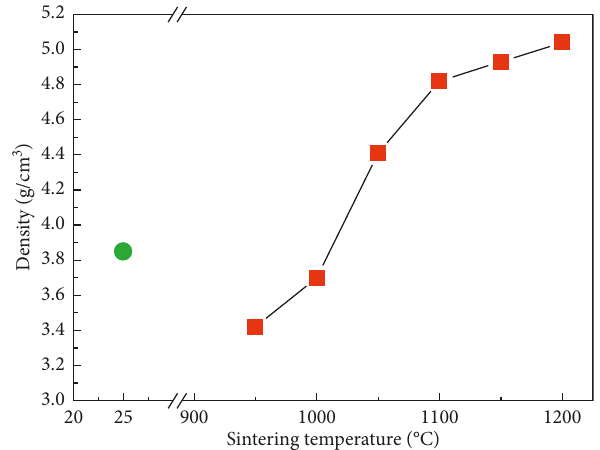
Figure 1: The morphology of the PSPP with the same initial new solid phase (Gd (unsintered), (b) sintered at 950 ° C, (c) 1000 ° C, (d) 1050 ° C, (e) 1100 ° C, (f) 1150 ° C, and (g) 1200 ° C.